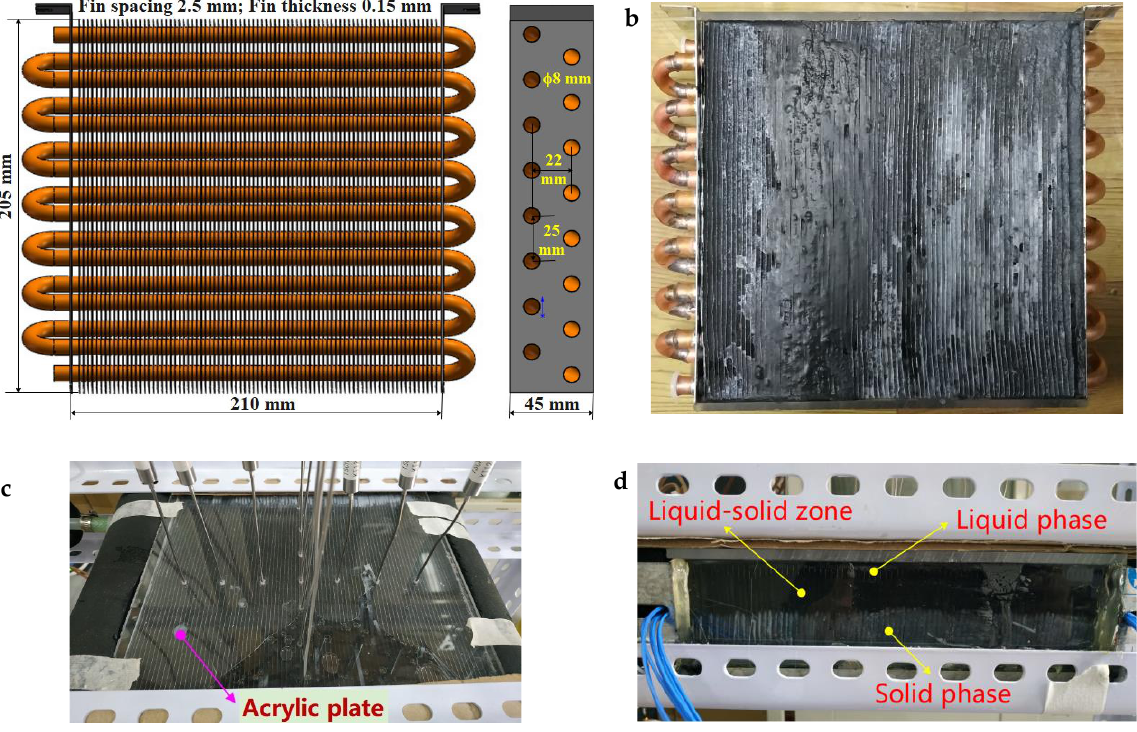
Figure 4. ( a ) Finned coil-type structure and parameters; ( b ) Filling with PCMs; ( c ) Temperature probe locations; ( d ) Observation surface.